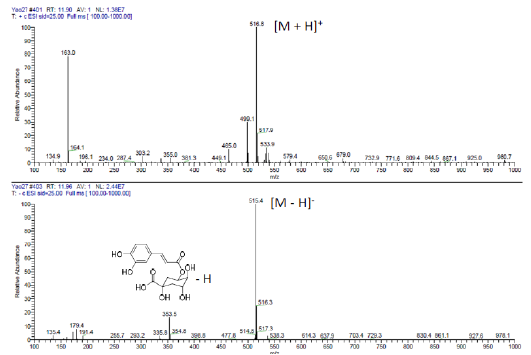
Figure 2. ESI-MS spectrum of compound 3 The 1 H NMR data were very similar to those of 3 for the caffeic acid moieties [7].